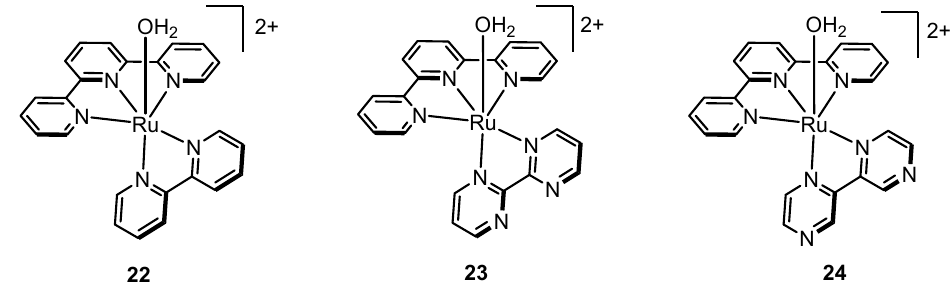
Figure 9. ( a ) Ce IV -mediated mechanism proposed by Meyer’s group of water oxidation by Ru(tpy)(bpy) complexes, ( b ) mechanism proposed by Pushkar.